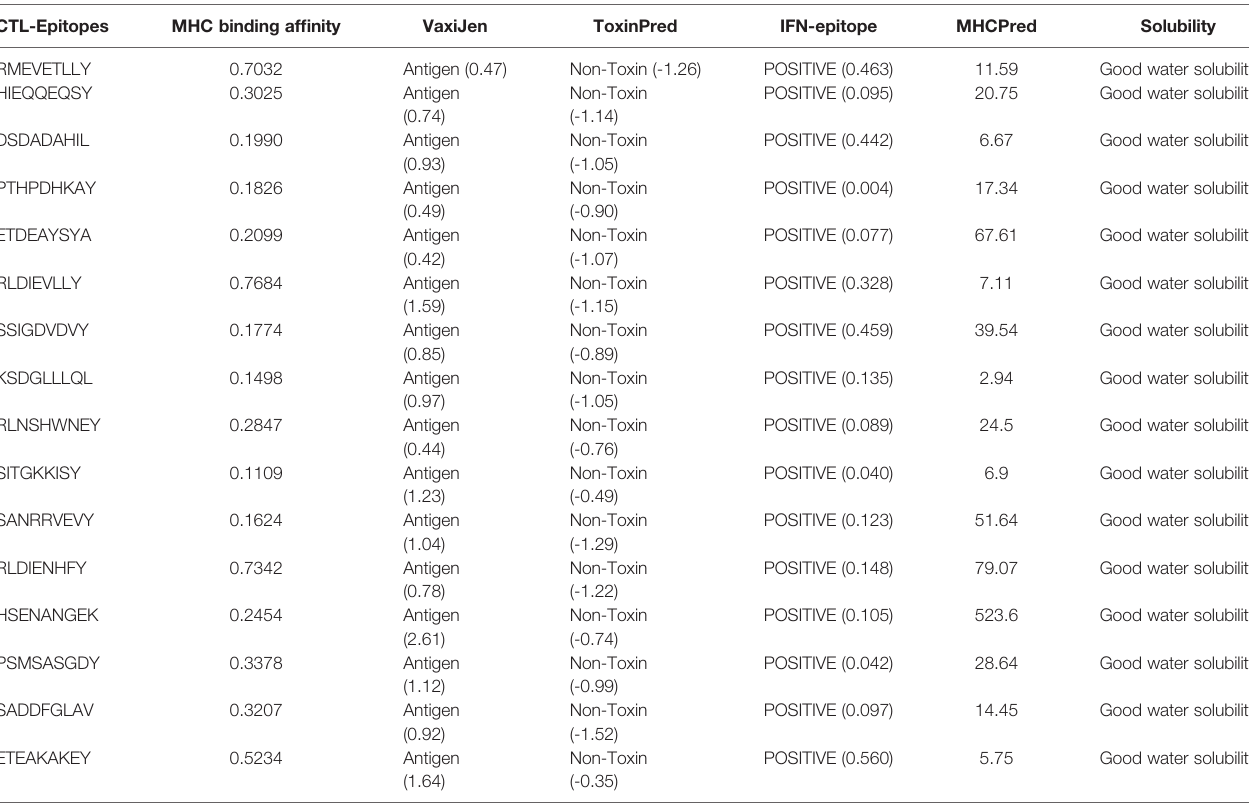
TABLE 2 | Selected MHC-I epitopes for vaccine construct.